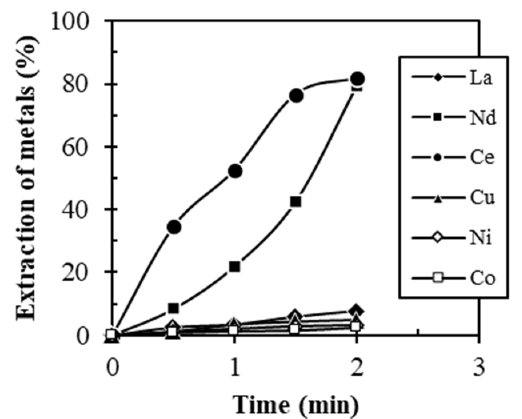
Figure 8. Solvent extraction of Ce and Nd from leach liquor [Metal concentration in leach liquor (g/L): Nd: 3.9; Ce: 11.9; La: 7.6; Cu: 6.5; Ni: 28.9; Co:5.1; extractant: 10% PC88A diluted in kerosene; time: 10 min; O/A ratio: 1/1].